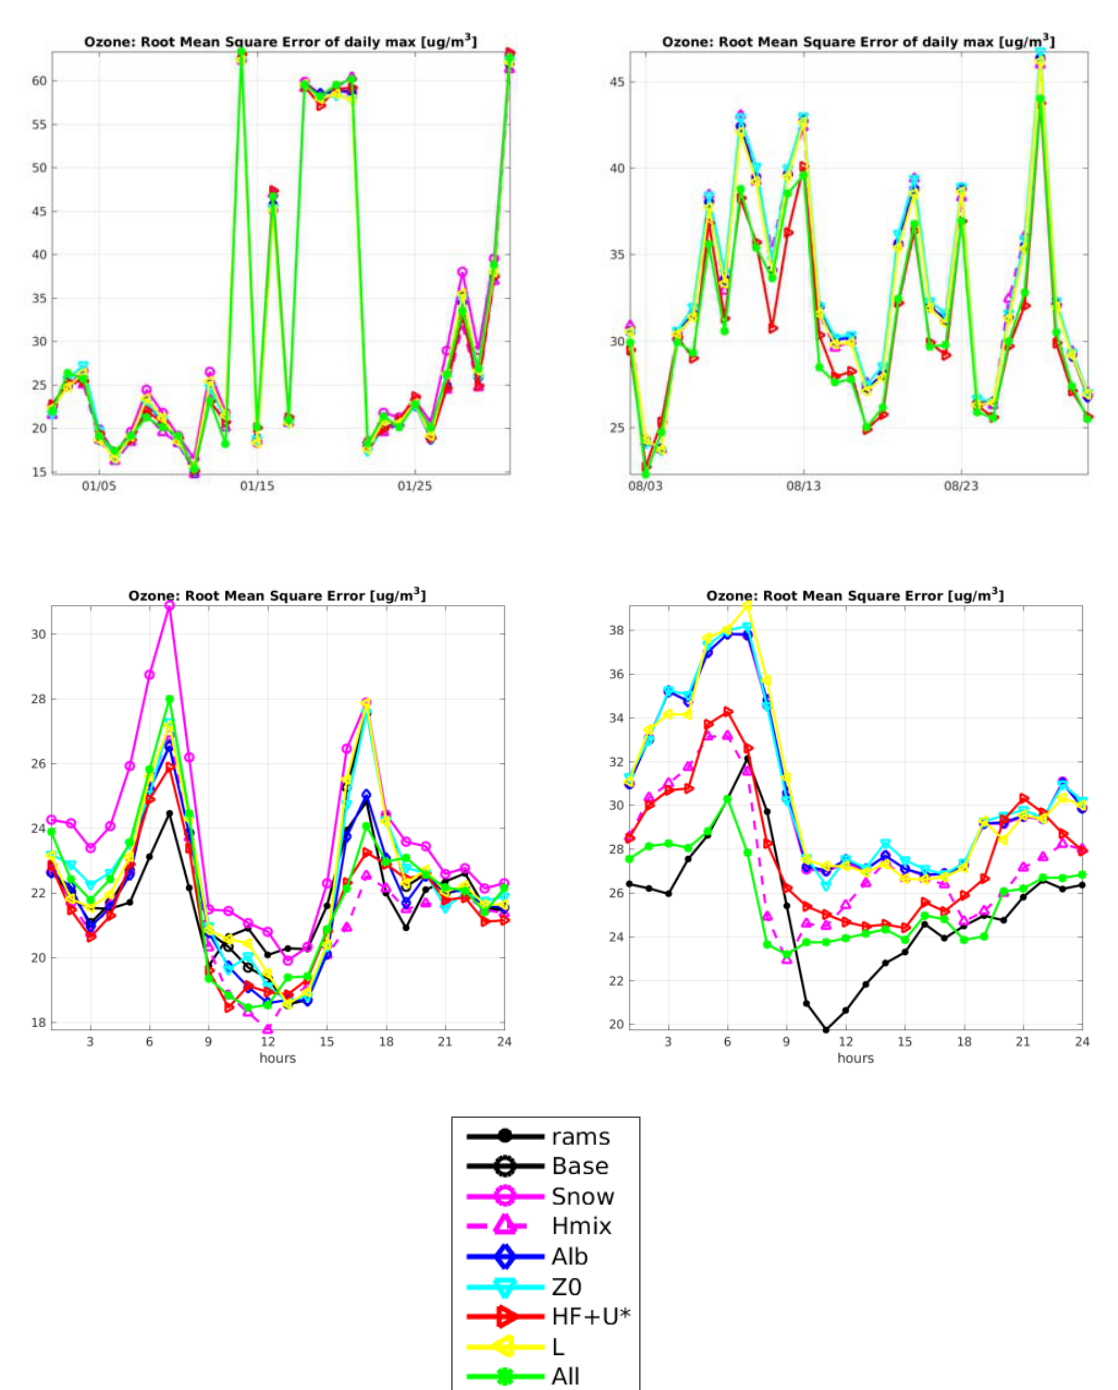
Figure 8. O 3 —RMSE of the daily maximum of hourly concentrations (upper panel) and of hourly concentrations (lower panel), for January (left) and August (right). The x ‐ axis reports UTC times. Values of R ( Figure 9, upper panel) are between 0.24 and 0.44 in January and between 0.23 and 0.52 in August. In January, the average pattern is a W ‐ shape, it shows descending values at night, with the absolute minimum between 7.00 and 8.00, then a sharp rise until 11.00, followed by a decrease towards a relative minimum value at 21.00, then, again, a rapid increase, until 23.00. HF+U* is the best configuration during night time, Hmix has the highest values from 10.00 to 20.00, Z0 gives the best results at 21.00 and 22.00. August values show a different pattern, with lower values at night